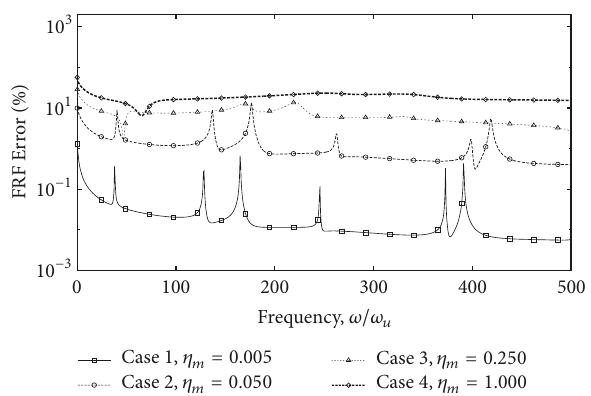
Figure 6: Example 2: viscoelastic 1D structures. Relative error (%) between frequency response functions of the viscoelastic model (exact) and the viscous approach (proposed) for the four cases shown in Table